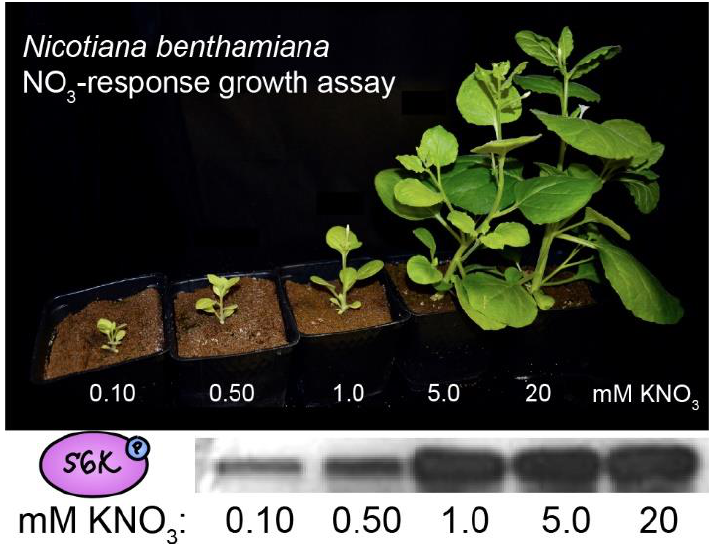
Figure 3. TOR monitors nitrogenous nutrient availability in plants. Plants can synthesize all 20 proteinogenic amino acids from inorganic precursors (nitrate or ammonium, carbon dioxide, and sulfate). N. benthamiana were grown on calcined clay and supplied with standard nutrients except for nitrogen, which was supplied as potassium nitrate at the indicated concentrations. Nitrate strongly stimulated plant growth and activated TOR, as measured by Western blots using phosphospecific antibodies against the canonical TOR substrate, S6K-pT449 (methods as in [13]). A major outstanding question in plant metabolic signaling is whether plant cells encode true amino acid sensors analogous to the aforementioned mammalian amino acid sensors for TOR. Amino acid profiles of ipms1 mutants, which show constitutively elevated TOR activity, revealed altered levels of almost every amino acid except for lysine and methionine [28]. The relative potency of TOR activation by amino acids was not clearly resolved by experiments using other mutants in the branched-chain amino acid biosynthetic pathway [28]. In leaf discs floated on solutions containing either isoleucine or glutamine at night, TOR activity was rapidly induced [29]; no amino acids were conclusively shown to be incapable of activating TOR, but glutamine had a stronger effect on TOR activity than isoleucine [29]. In Arabidopsis seedlings grown for 9 days without any source of nitrogen, TOR became inactive and growth was arrested. Supplying most amino acids to these nitrogen-starved seedlings activated TOR within minutes, except for arginine, proline, and the aromatic amino acids phenylalanine, tryptophan, and tyrosine [30]. Nitrate and ammonium may also activate TOR in this experimental system, even in the presence of tungstate (a nitrate reductase inhibitor) or methionine sulfoximine (a glutamine synthetase inhibitor), which prevent the assimilation of nitrogen into amino acids [30]. This may suggest that TOR specifically senses inorganic forms of nitrogen in plants and that amino acids supplied to N-deprived seedlings are catabolized to yield inorganic nitrogen forms. Alternatively, plant TOR may monitor multiple nitrogenous cues, including inorganic nitrogen and diverse amino acids, analogous to the diversity of amino acids and amino acid related metabolites sensed by mammalian TOR. To summarize, although current